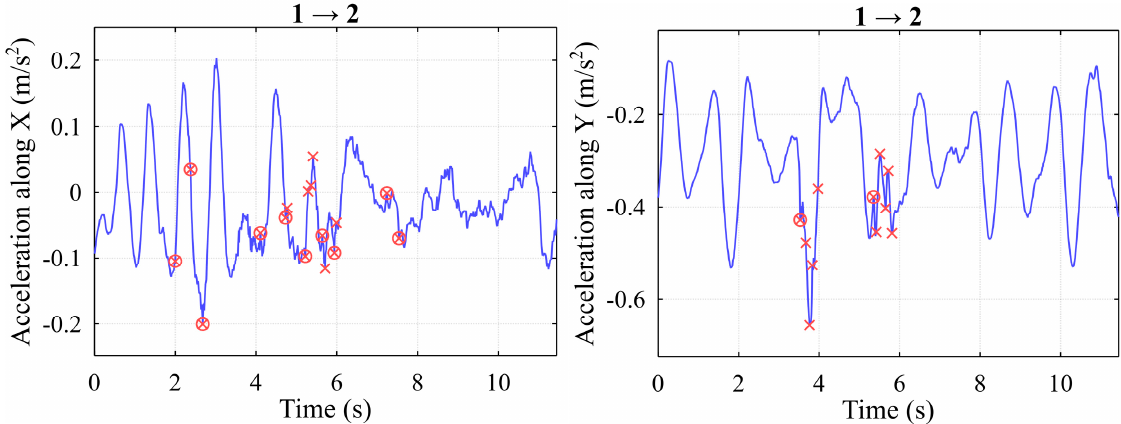
Figure 17. Use case No. 3 with the decreased threshold (detected impacts: ( left ) 10; ( right ) 2). Further changes to the level of the threshold ( ±20% ), with smaller steps ( ±2% ), gave